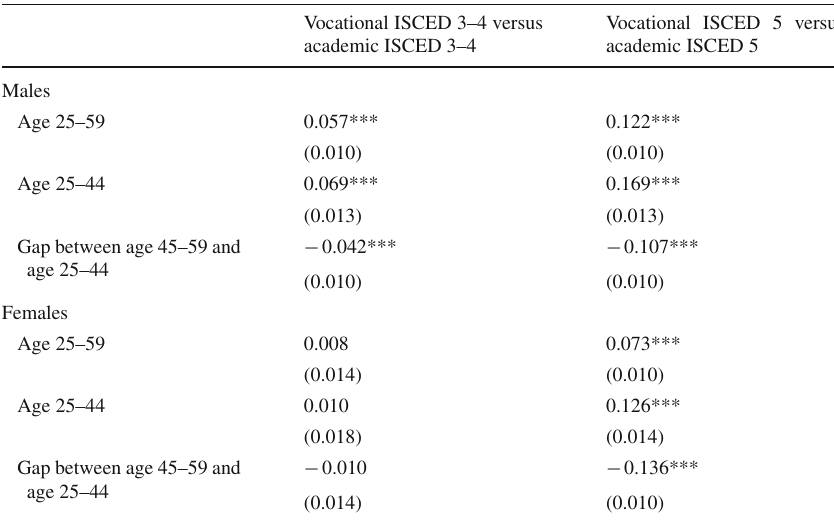
Table 10 Average treatment effects of vocational education relative to academic education. Dependent variable: years of work/(age-14). Source : Calculations based on PIAAC data Vocational ISCED 3–4 versus academic ISCED